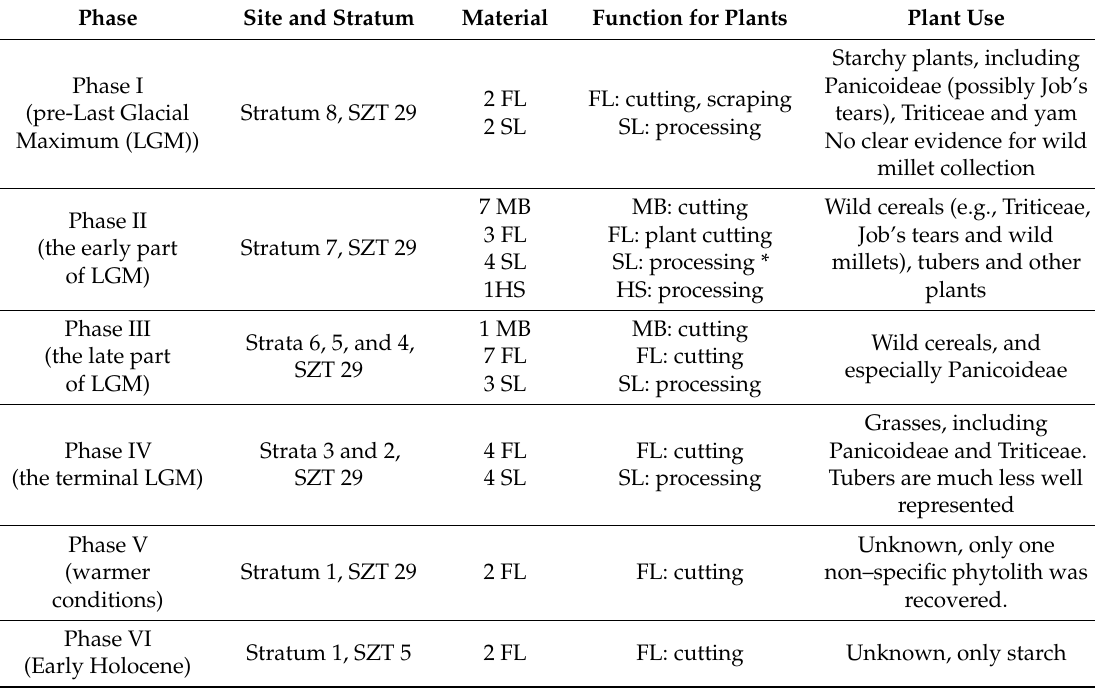
Table 4. Phases of plant use at the Shizitan (SZT) site (data collected from [31]). Phase Site and Stratum Material Function for Plants Plant